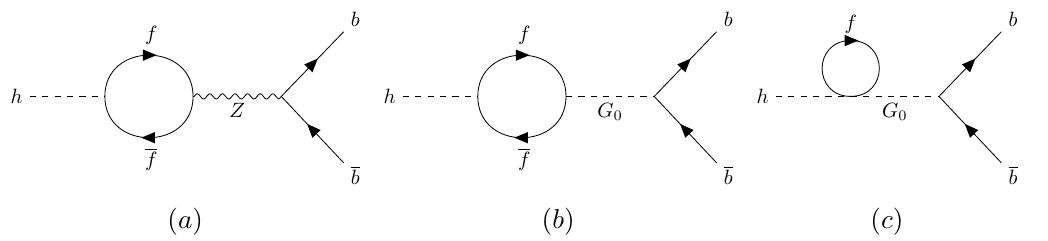
Figure 1 . Diagrams contributing to the partial width of h ! bb from Higgs mixing to (a) Z -boson and (b,c) neutral Goldstone